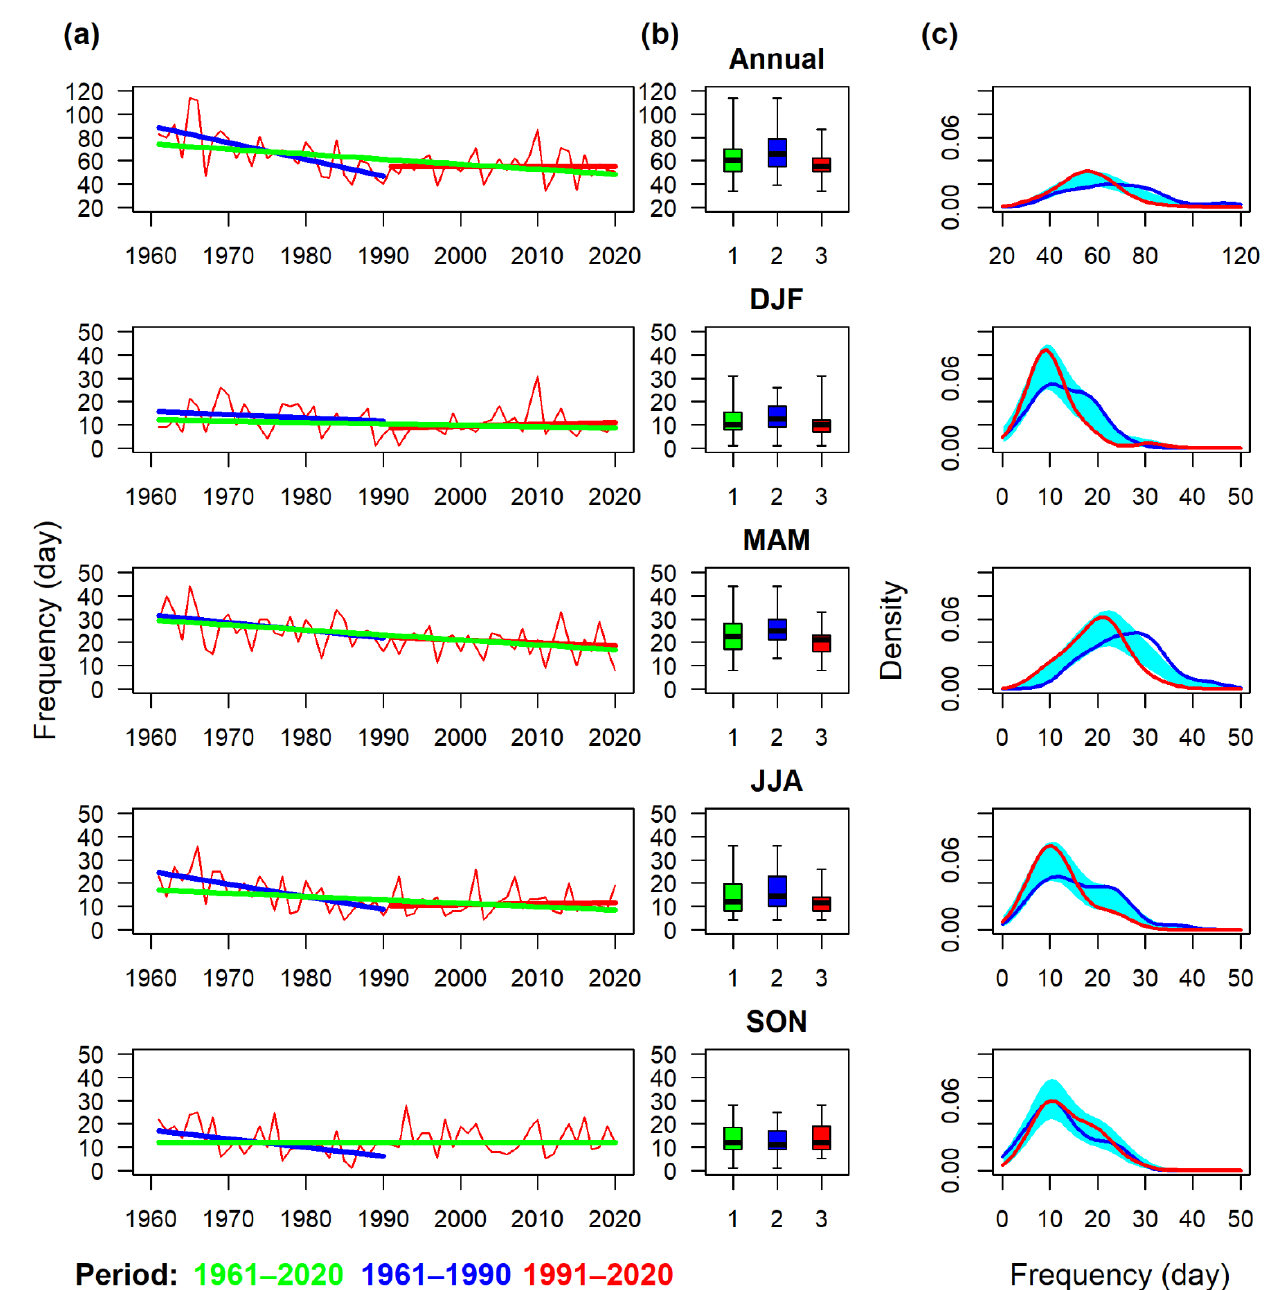
Figure 3. Annual and seasonal frequencies of days with cyclonic circulation types according to the objective classification for the territory of the Czech Republic in the 1961–2020 period: ( a ) fluctuations with linear trends in the entire period, 1961–1990 and 1991–2020; ( b ) box plots (median, lower and upper quartile, minimum, and maximum) for 1961–2020 (1), 1961–1990 (2), and 1991–2020 (3); ( c ) the density distribution of the series in 1961–1990 and 1991–2020. The density curves outside the reference band (green–blue) indicate a significant difference in the two distributions (and vice